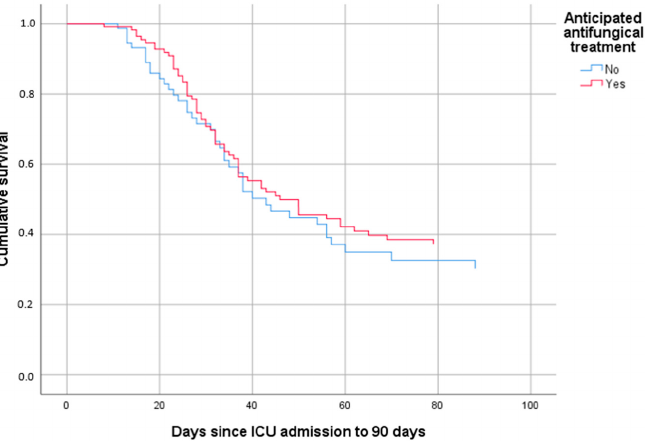
Figure 2. Overall mortality at 90 days from ICU admission in patients with SARS-CoV-2 infection with and without early antifungal treatment at ICU admission.